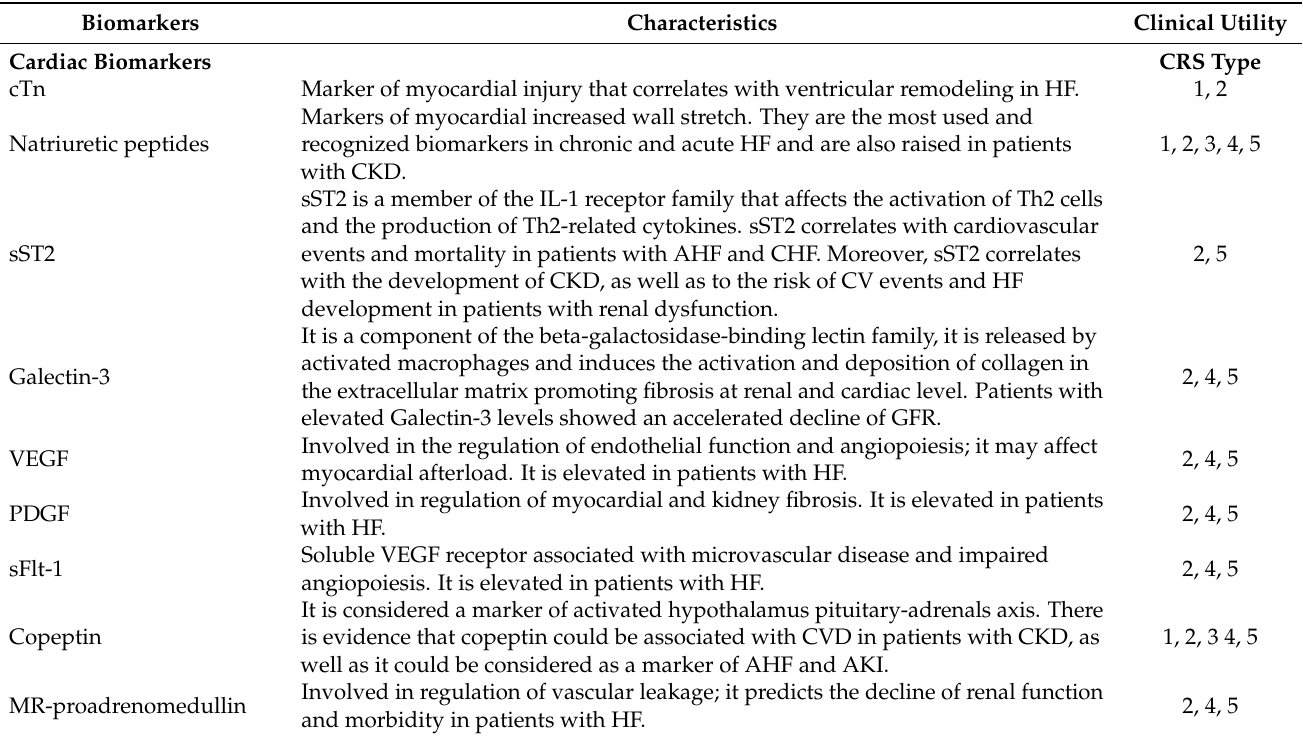
Table 2. Biomarkers in Cardiorenal